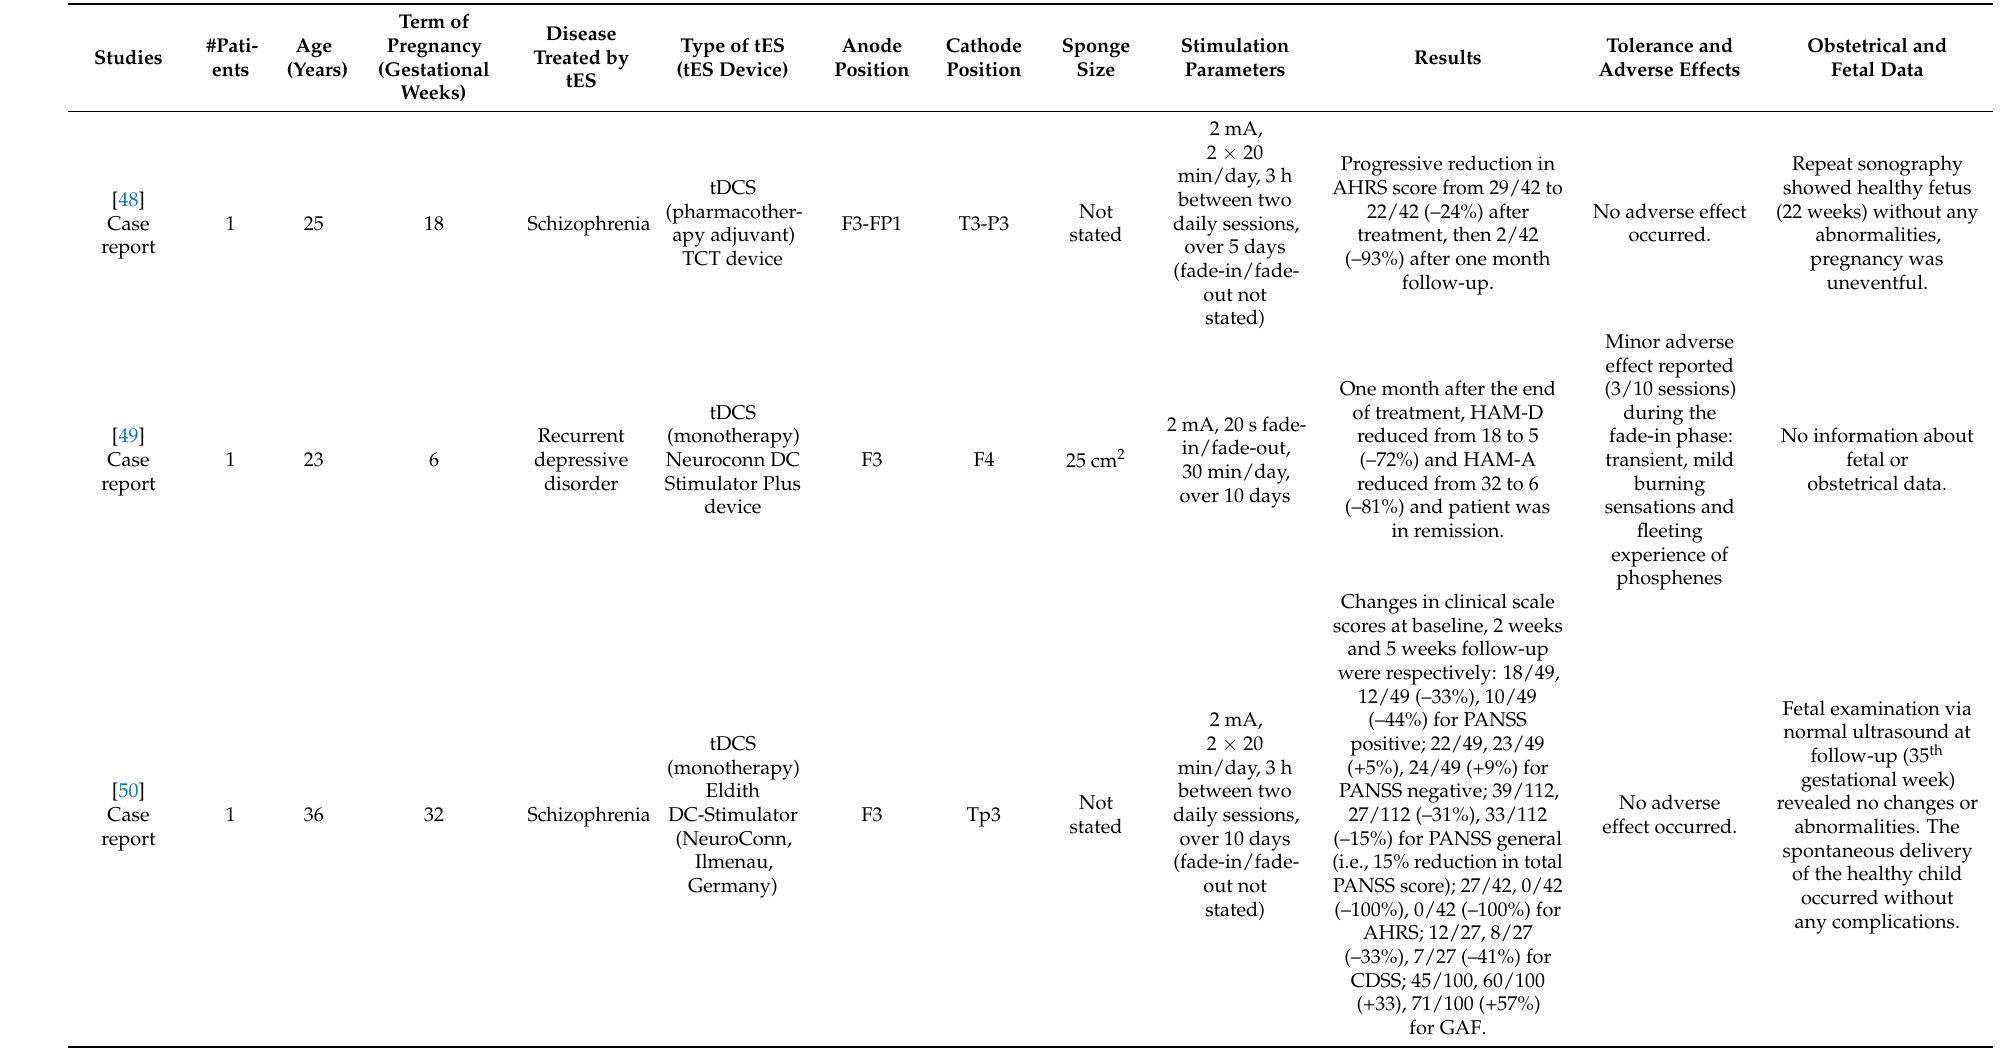
Table 1. Efficacy and tolerance of transcranial electric stimulation (tES) studies during perinatal